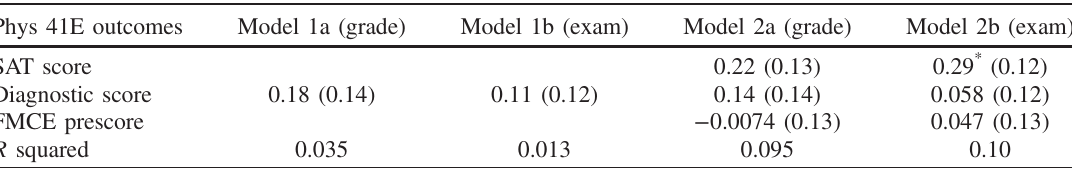
TABLE IV. Regression of Phys 41E course and exam grades on measures of incoming preparation. * p < 0 . 05 . Phys 41E